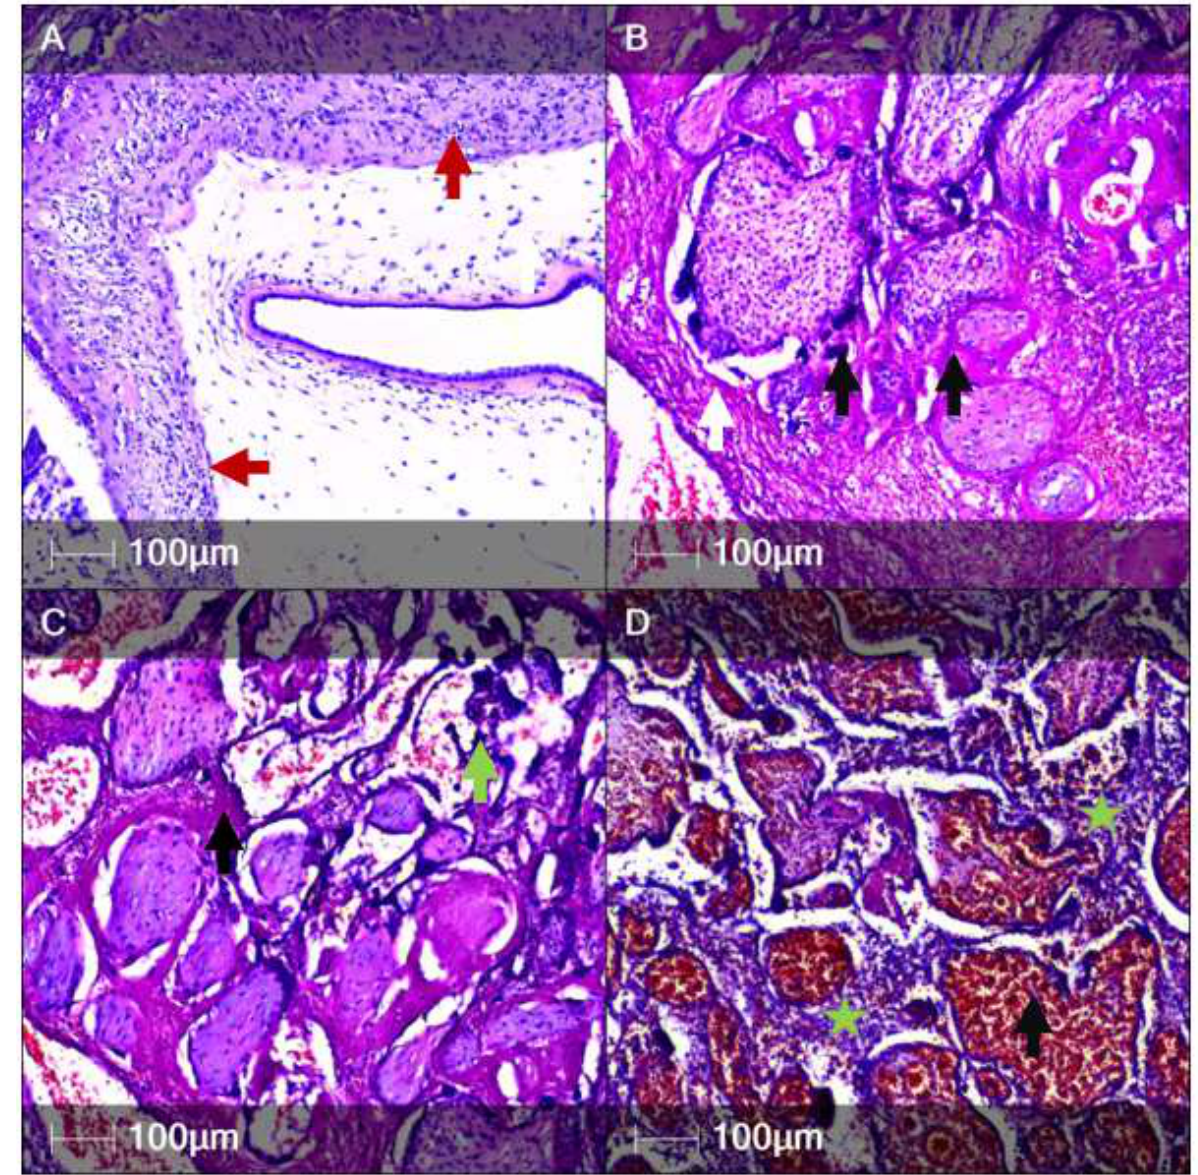
Figure 1. Histological examination of the placenta (H&E staining). The panel depicts various components and pathological features of the placenta. ( A ) Acute chorioamnionitis with signs of necrosis and leukocytoclasis (red arrows); ( B ) Subamniotic placentitis with intervillous thrombi (white arrow) and necrotic syncytiotrophoblasts (black arrows); ( C ) Syncytiotrophoblast necrosis (dark blue, green arrow) and intevillous cell debris (black arrow); ( D ) Subamniotic placentitis with predominantly intervillous neutrophil infiltrates (intervillositis—green asterisk) and severe intravillous congestion and haemorrhages (black arrow).